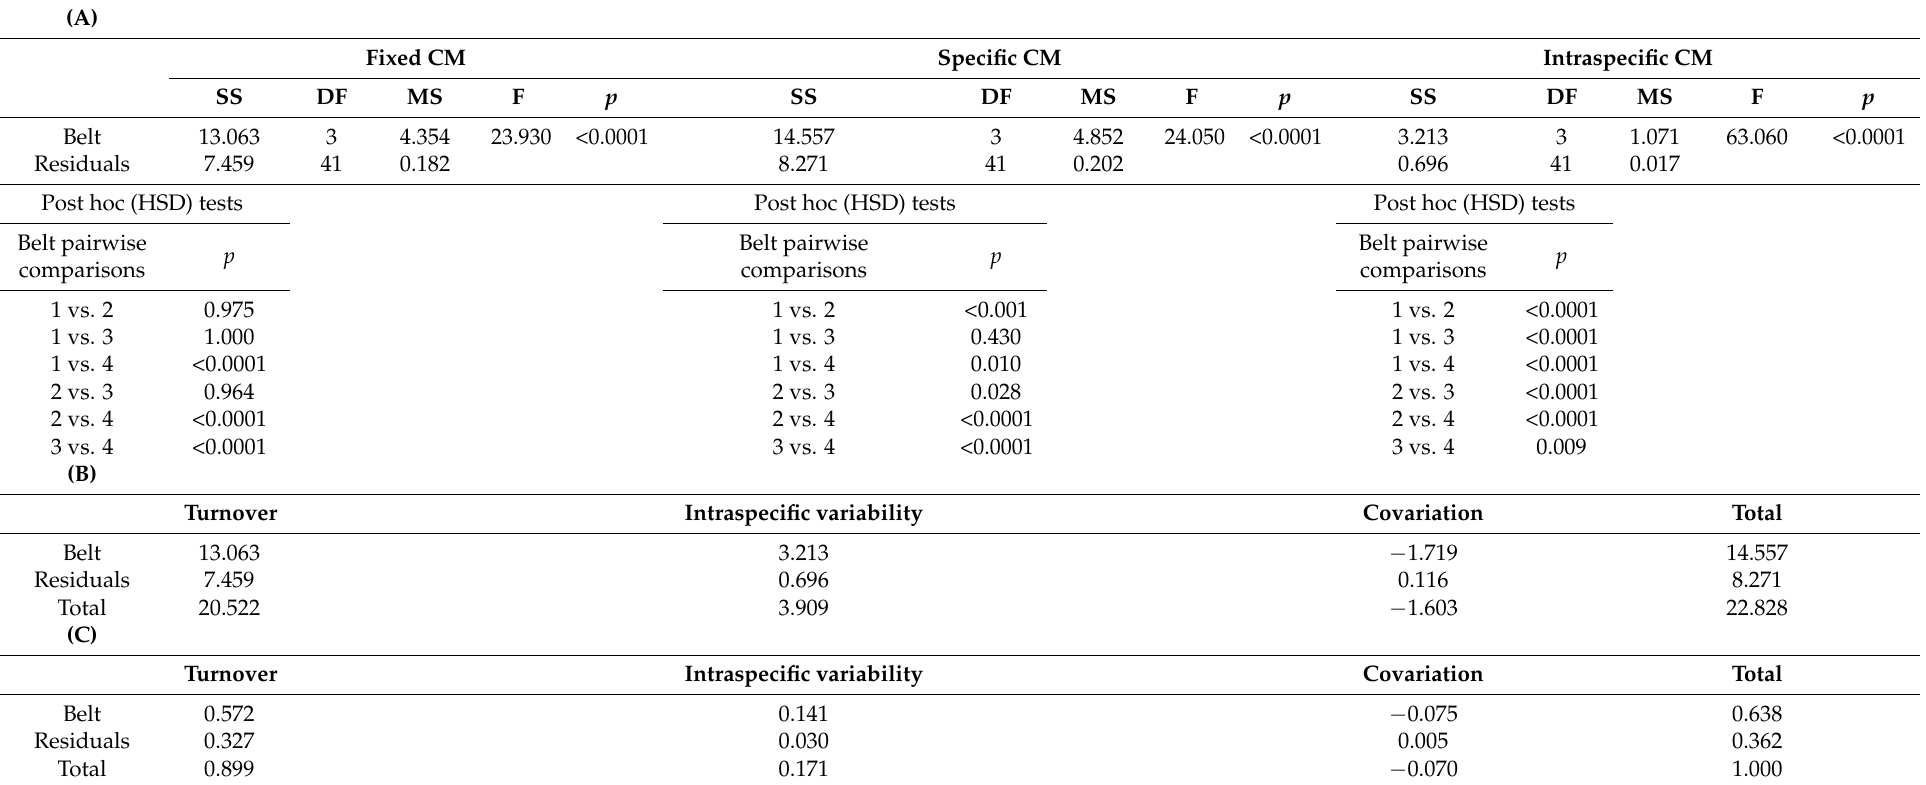
Table 6. Results of ANOVAs for CM of seed mass. ( A ) ‘Fixed’ and ‘specific’ averages and intraspecific variability effect were analyzed separately (one-way ANOVA), followed by post hoc (HSD) tests for pairwise comparisons. ( B ) Variability of individual components of trait variation (turnover, intraspecific and their covariation) between belts. ( C ) Proportions of variability of individual components and their parts explained by elevation (belt). For details, see Table